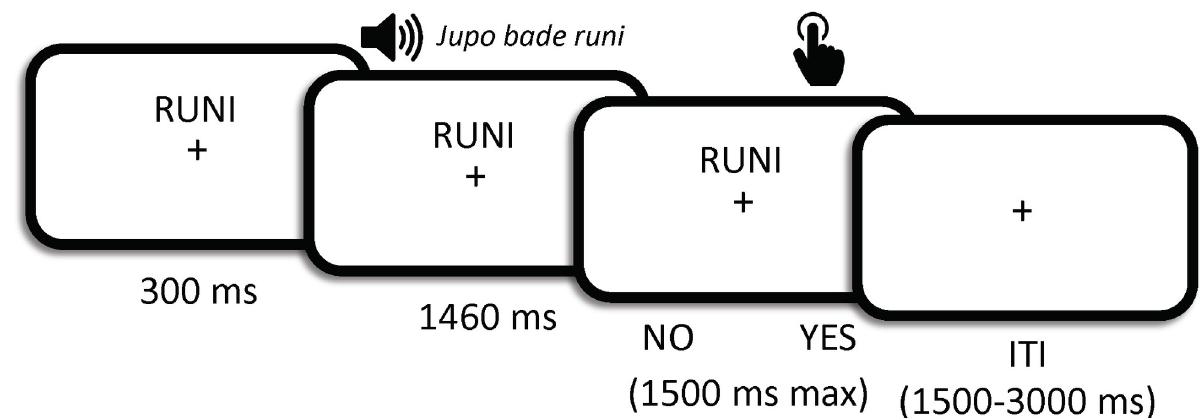
Fig 1. NAD learning task. The same procedure was used for the behavioral and fMRI groups, except for the ITI, lasting 1 second in the behavioral group and jittered between 1.5 and 3 seconds in the fMRI group. Participants were requested to indicate, via a button press, whether the target word was present (YES) or absent (NO) after listening to each phrase, with a maximum of 1.5 second allowed for response. RTs were calculated from the onset of the third word of each phrase. Trial (i.e., event) onsets for fMRI analyses were set to the beginning of each phrase. fMRI, functional magnetic resonance imaging; ITI, intertrial interval; NAD, nonadjacent dependency; RT, reaction time.